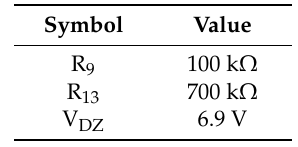
Table 1. Practical values components of the logarithmic amplifier